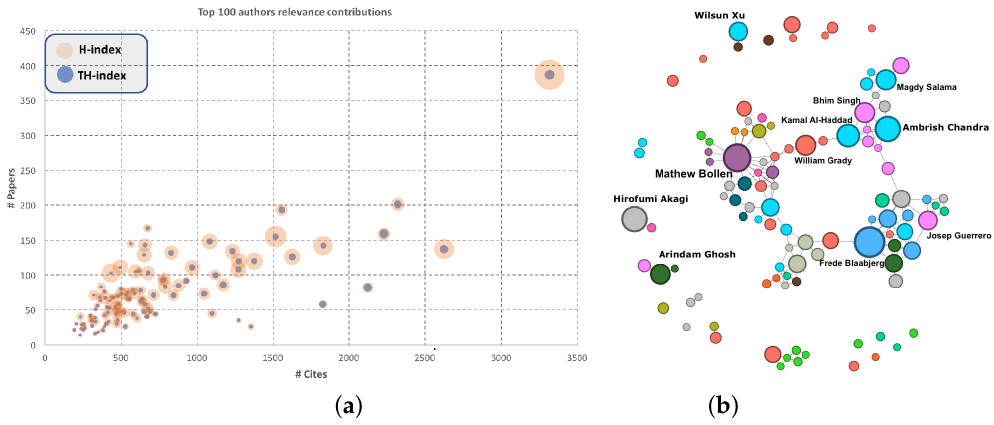
Figure 5. ( a ) number of citations and articles of the top 100 researchers with the highest TH-index in power quality; ( b ) collaboration network of the 100 top researchers in power